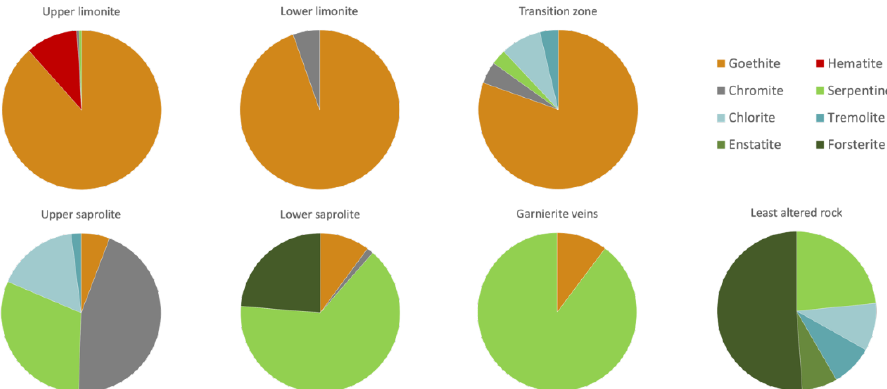
Figure 2. The laterite profile is subdivided into five subzones based on the mineralogy. The topmost zone is the upper limonite subzone, dominated by goethite with minor hematite, and is underlain by the lower limonite subzone composed of goethite and minor chromite. The transition to the saprolite is marked by the first appearance of silicate minerals and a decrease in goethite abundance. The saprolite zone is marked by the dominance of Mg-silicates and a decrease in the abundance of goethite. The upper saprolite subzone is comprised mostly of serpentine, with minor chlorite and tremolite. The lower saprolite subzone is distinguished by the presence of relict olivine. The sample taken at a depth of 10.5 m represents the least altered rock in the profile. This sample is moderately serpentinized (~40%) and has significant primary minerals. Lastly, garnierite veins are composed of about 90 wt% serpentine and 10 wt% goethite. Note that abundant chromite of primary origin was observed in the upper saprolite zone. Data are obtained from Aquino et al. [34].